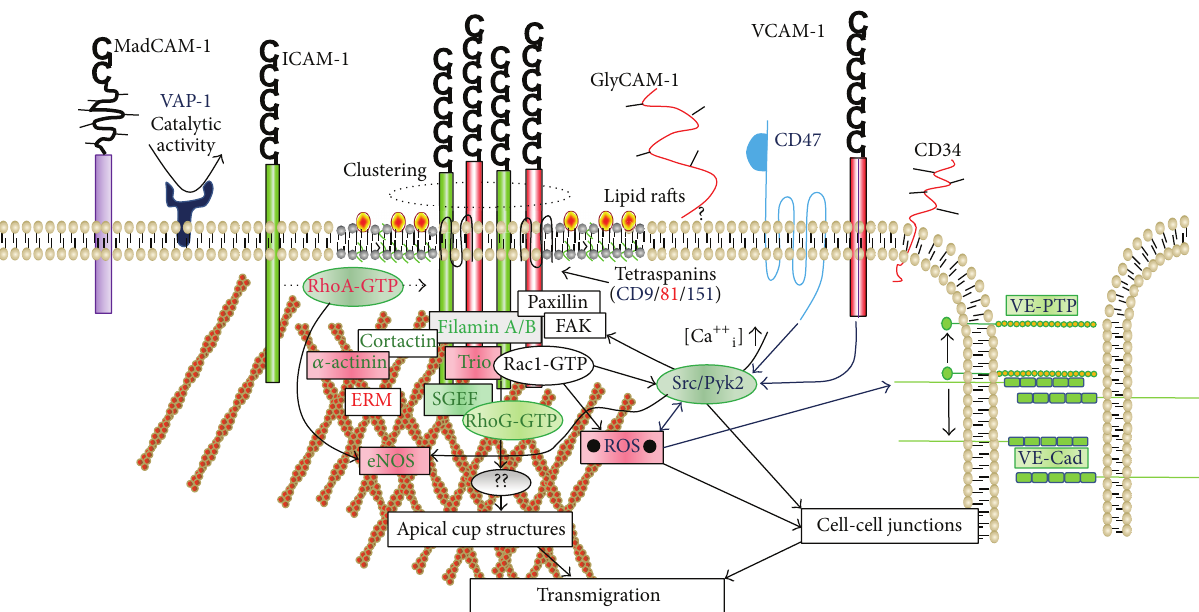
Figure 2: Endothelial signaling pathways induced upon clustering of ICAM-1 and VCAM-1 leading to the formation of endothelial F-actin- rich apical cup structures and the dissociation of endothelial adherens junctions. Endothelial signals that are induced by specific leukocyte types are color-coded: neutrophils in green, monocytes in red, T cells in blue, and B cells in purple. In case signaling proteins are identified by studies using different leukocyte types, the background color of the protein name is adapted to the leukocyte type used. In case specific signaling is studied in the absence of leukocytes the color is black. Short stripes indicate glycosylation. Question mark indicates that GlyCAM- 1, as a soluble protein, may reassociate to the endothelial